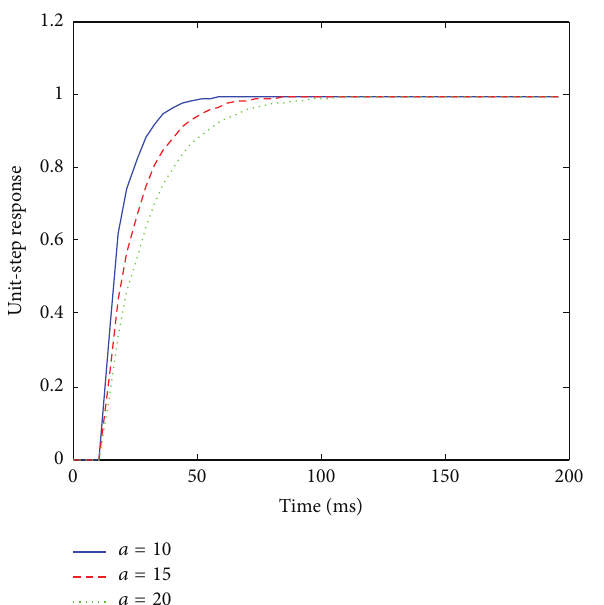
Figure 6: Different output results of the IMC controller.